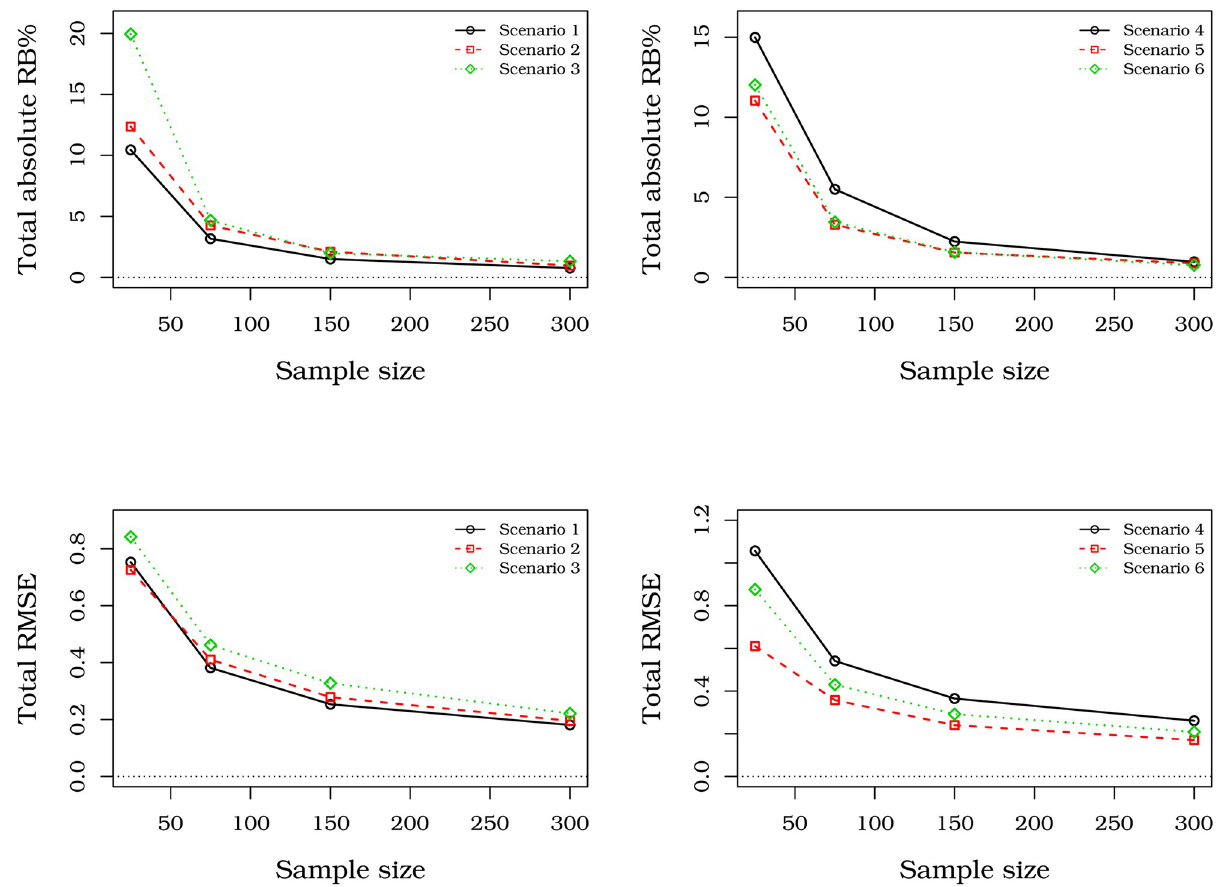
Fig 6. Total absolute RB%s and total RMSE of the MLEs from UBXII regression with different sample sizes.